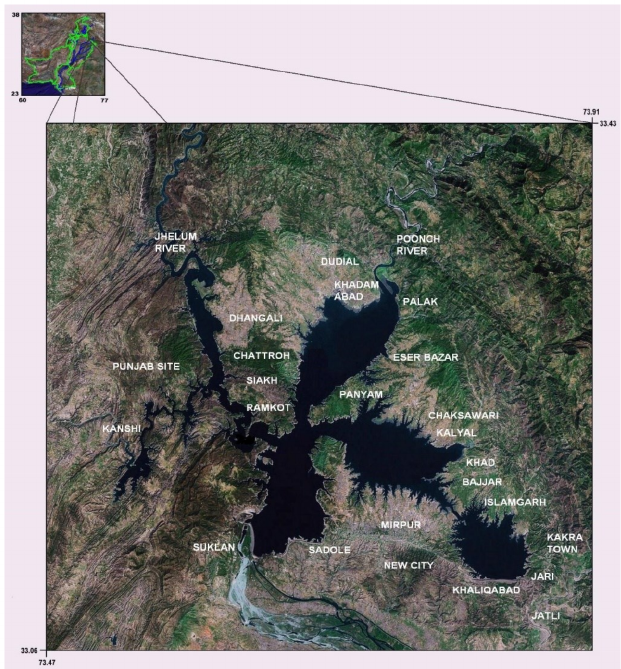
Figure 1. Location map of the study